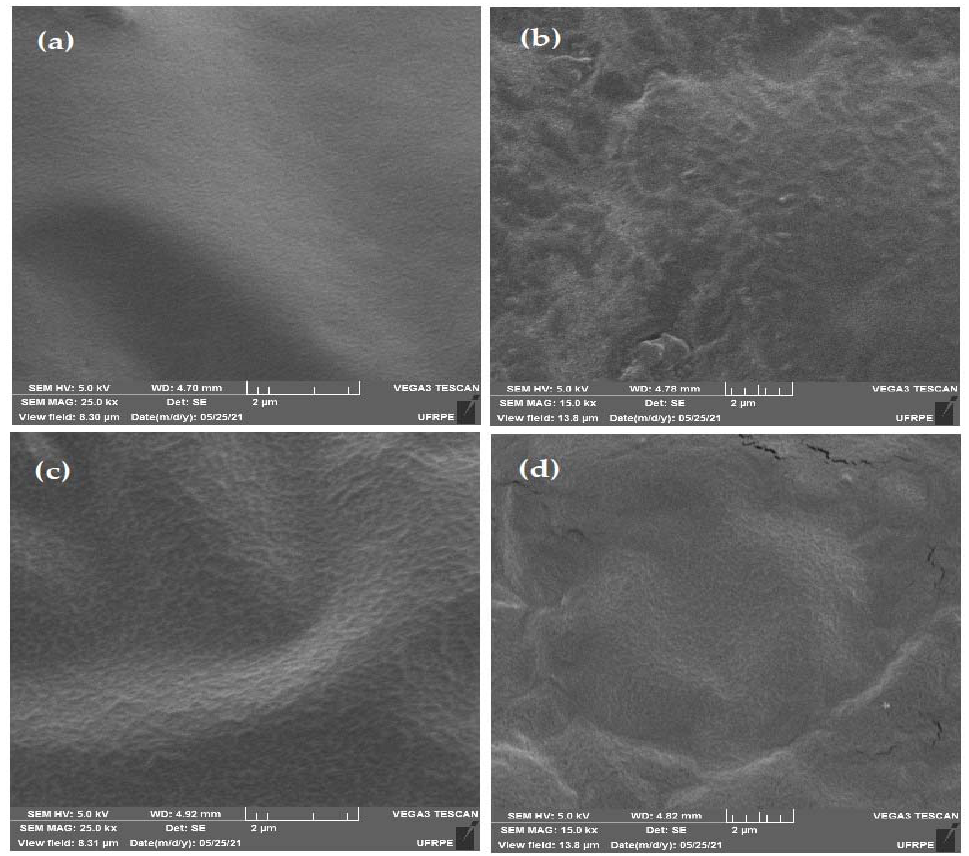
Figure 2. Surface microstructure of biopolymeric films enriched with different levels of cashew nut shell liquid (CNSL), including 0.5% ( b ), 1% ( c ), and 1.5% ( d ), in alginate matrix. Saline control ( a ).